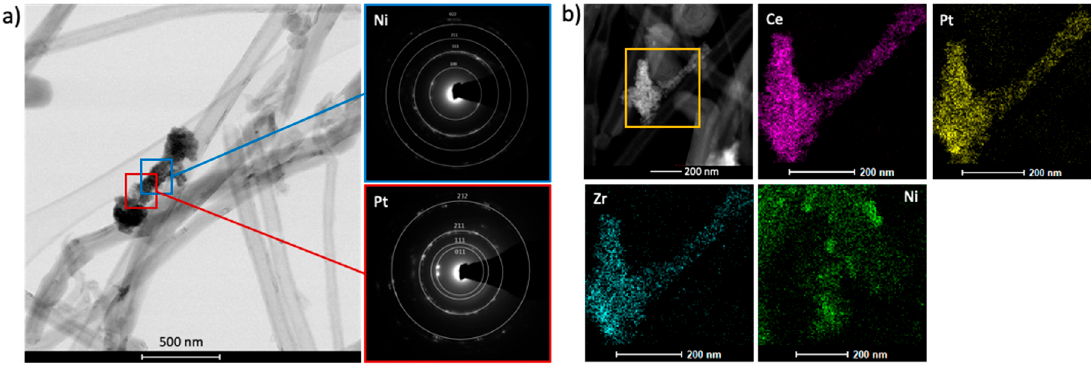
Figure 5. Bright field TEM with SAED ( a ) and Ce, Zr, Ni, Pt ( b ) for Pt-Ni-CZ/CFF. The specific surface area (SSA), total pore volume (V t ) and average pore diameter